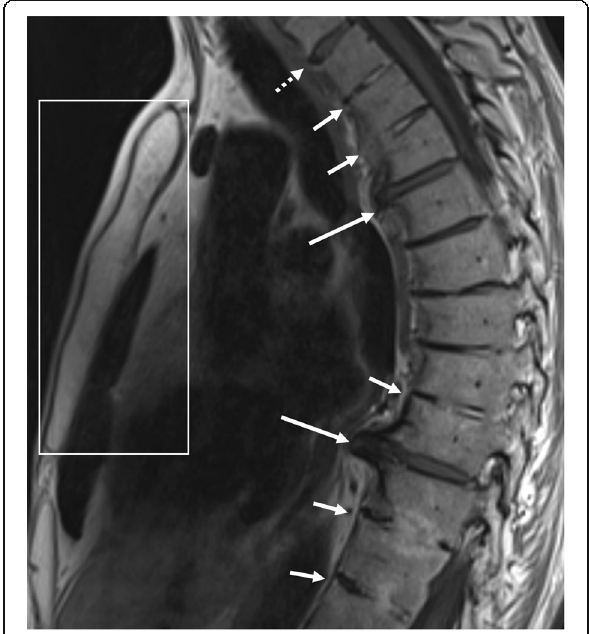
Fig. 8 Extensive — and several types of — new bone formation in one patient with SpA. Sagittal T1-weighted MR image shows how bony fusion of the manubriosternal joint can be observed on sagittal imaging of the spine in a routine SpA protocol (rectangle). Also, notice the other types of new bone formation: syndesmophytes (dotted arrow), discal high signal intensity and/ or progressive trandiscal ankylosis (short arrow), and osteophytes (long arrow). This image demonstrates that osteophytes can be seen in patients with SpA at levels otherwise unaffected by SpA, perhaps due to increased mechanical loads on the remaining functional disco-vertebral units